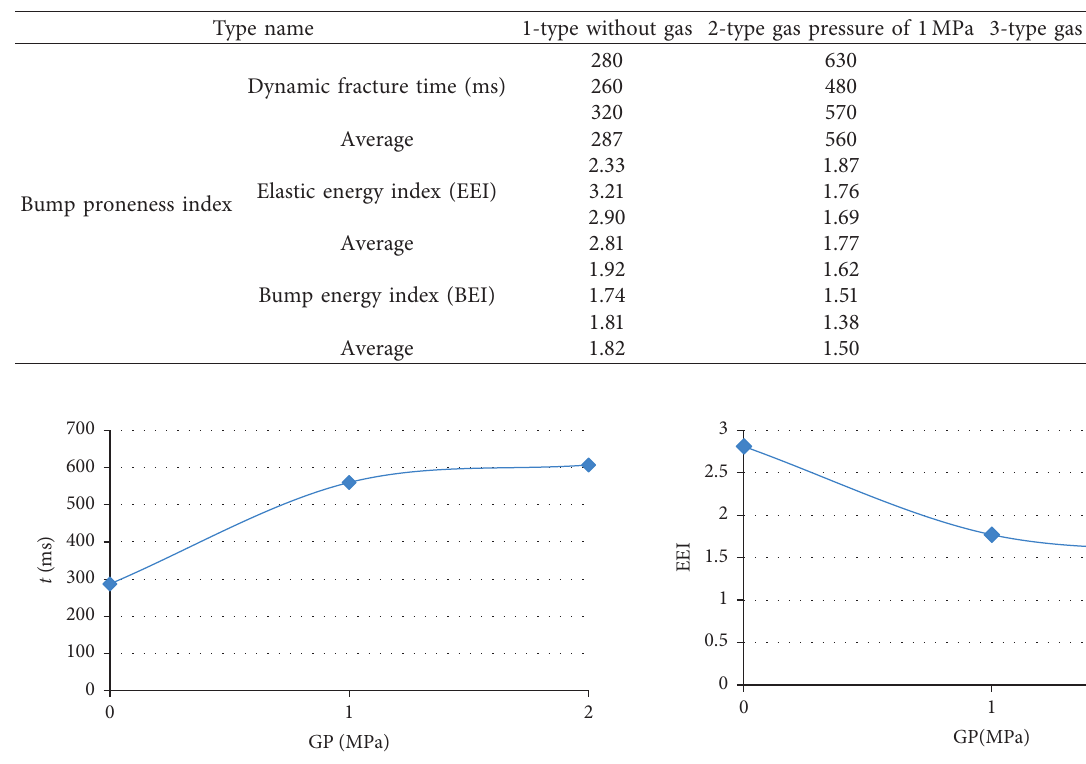
Table 1: Experimental results of coal bump proneness index under different gas pressure conditions.